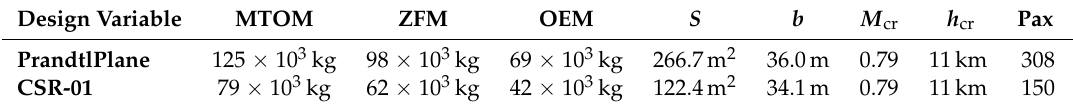
Table 3. Top-level design requirements of the PrandtlPlane and CSR-01